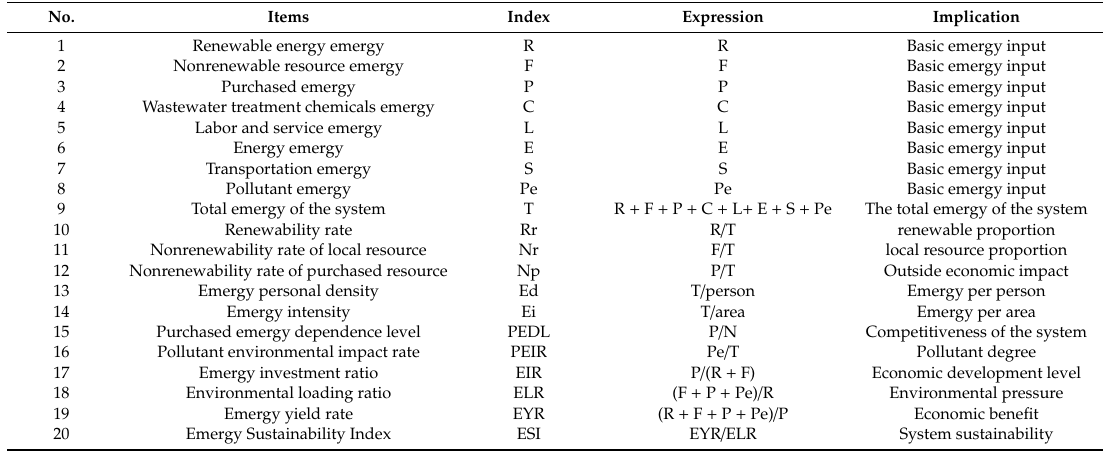
Table 7. All indicators of emergy for the new sewage treatment